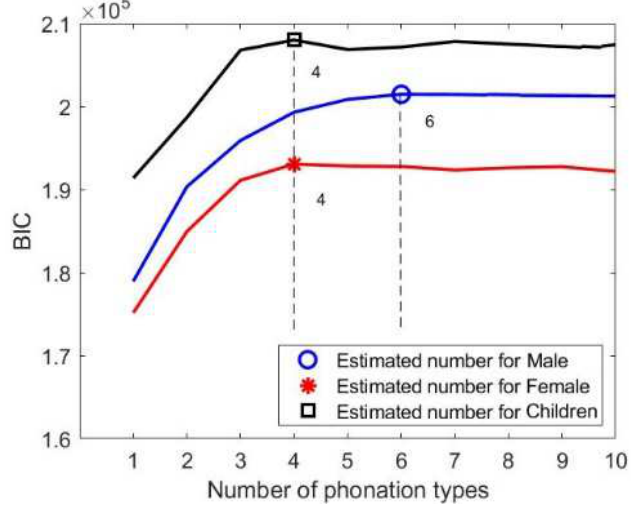
Figure 4. BIC value, the maximum of which indicates the optimum number of clusters when using all six voice metrics. The circle marker represents the optimum for male voices of 6 clusters. For both female (star marker) and child voices (square marker), the optimum is 4 clusters.